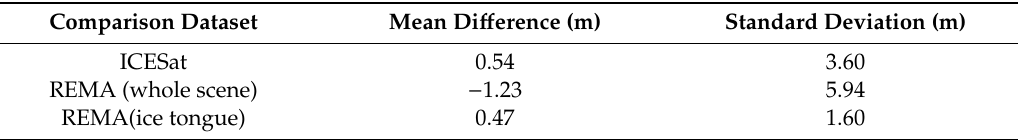
Table 3. Accuracy analysis of the Worldview